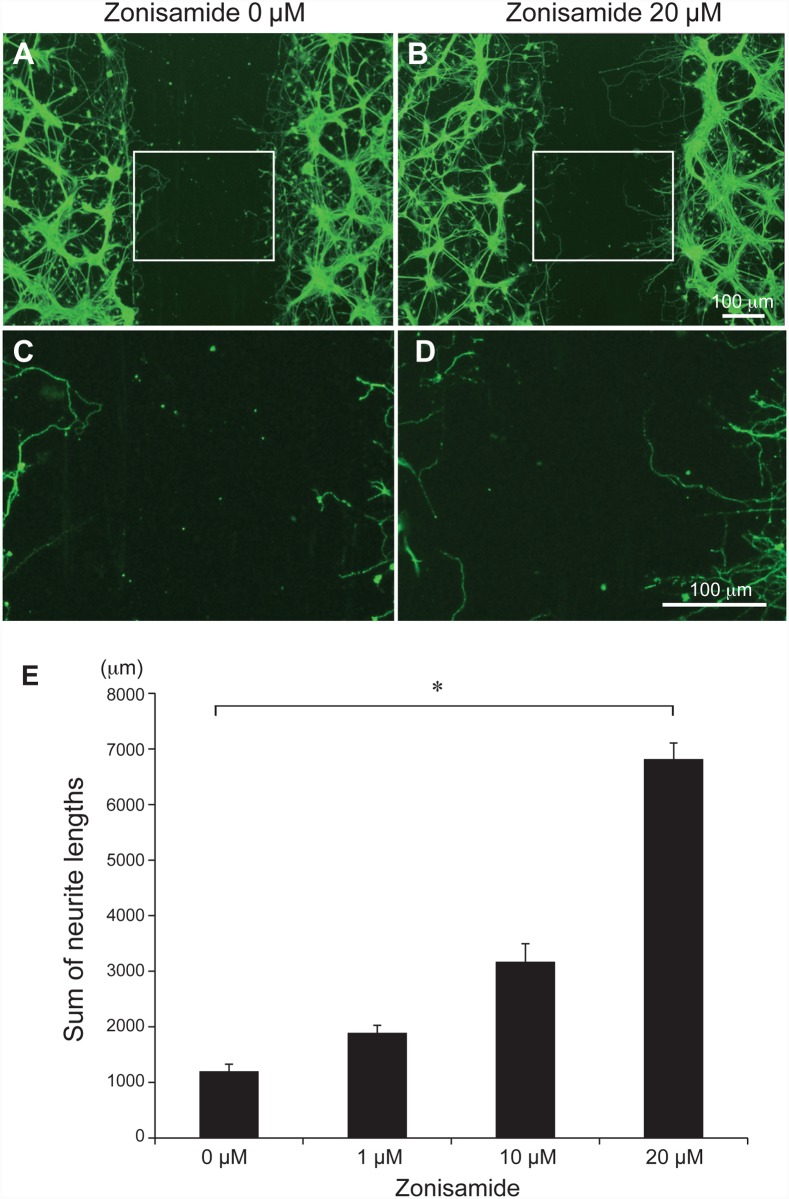
Zonisamide induces regeneration of neurites in primary motor neurons.
(A-D) Differentiated primary motor neurons were scratched to evaluate their ability to regenerate neurites. Newly elongated neurite lengths into the scratched area after 48 h were automatically measured by the MetaMorph. Boxed areas in (A) and (B) are magnified in (C) and (D). (E) The sum of regenerated neurite lengths in the square area (250 μm × 1000 μm) within the scratched area are calculated in four visual fields and the mean and SE are indicated. *p < 0.05 by one-way ANOVA followed by Tukey HSD.